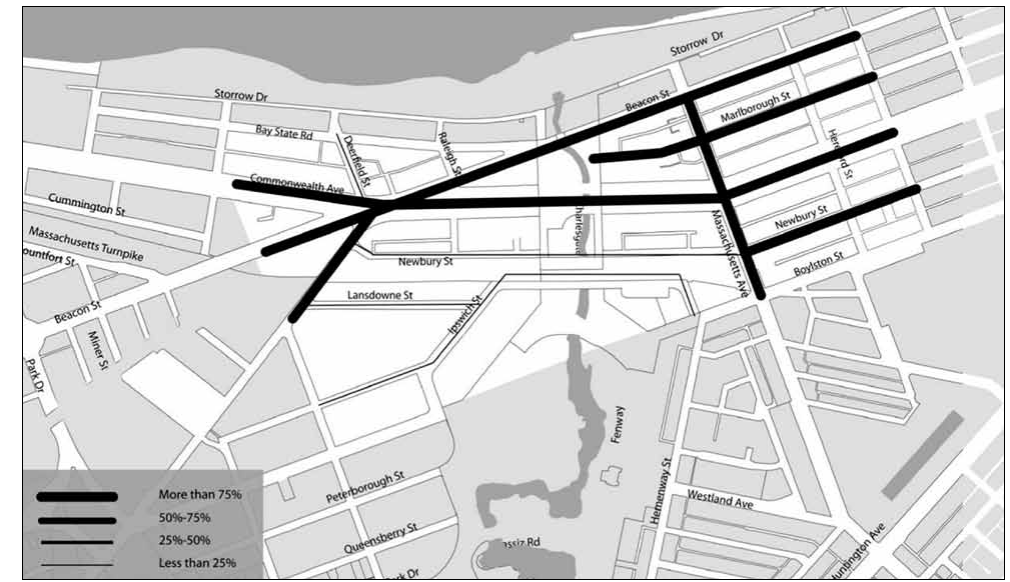
fig. 4. Kenmore compiled map of perceived streets based on surveys